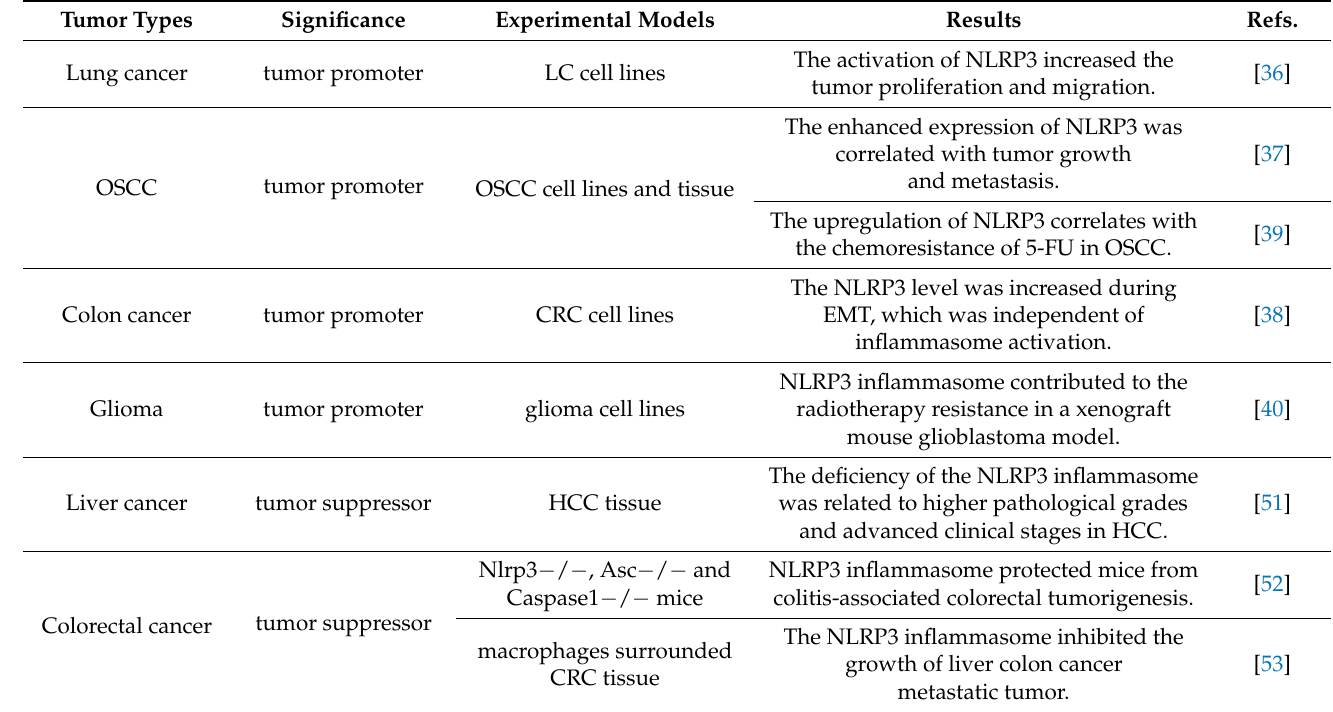
Table 1. Roles of the NLRP3 inflammasome in